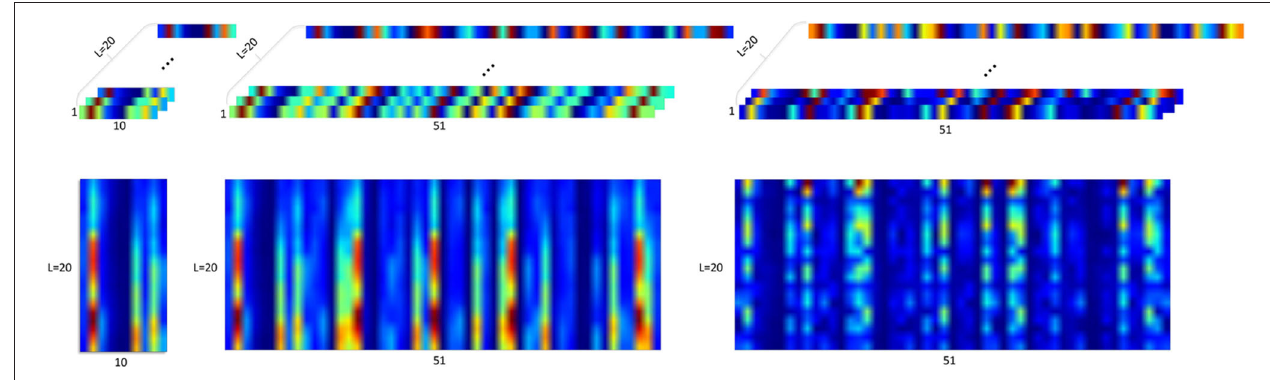
FIGURE 4 | Three surface electromyography (sEMG) image representation methods based on raw signal (Hu et al., 2018).